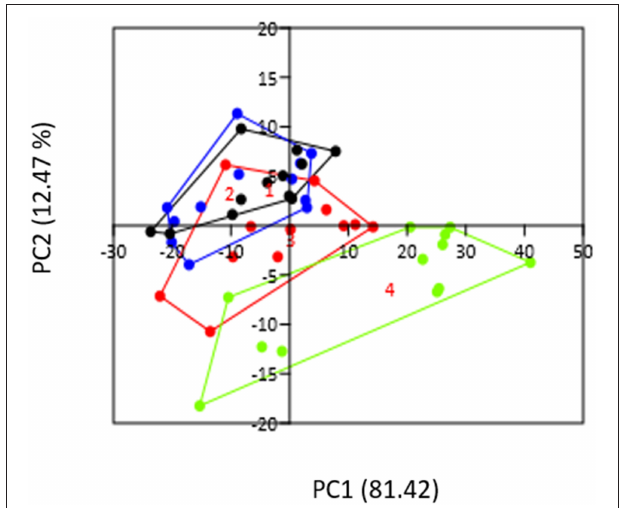
FIGURE 1 | PCA plot representing the gut microbiota of conventional pre-pregnant (black circles), day 7 (blue circles), day 14 (red circles), and day 18 (green circles) mice. The day of pregnancy (PC2) does explain part of the variation. PC1 explains 81.42% of the variation, while PC 2 explains 12.47% of the